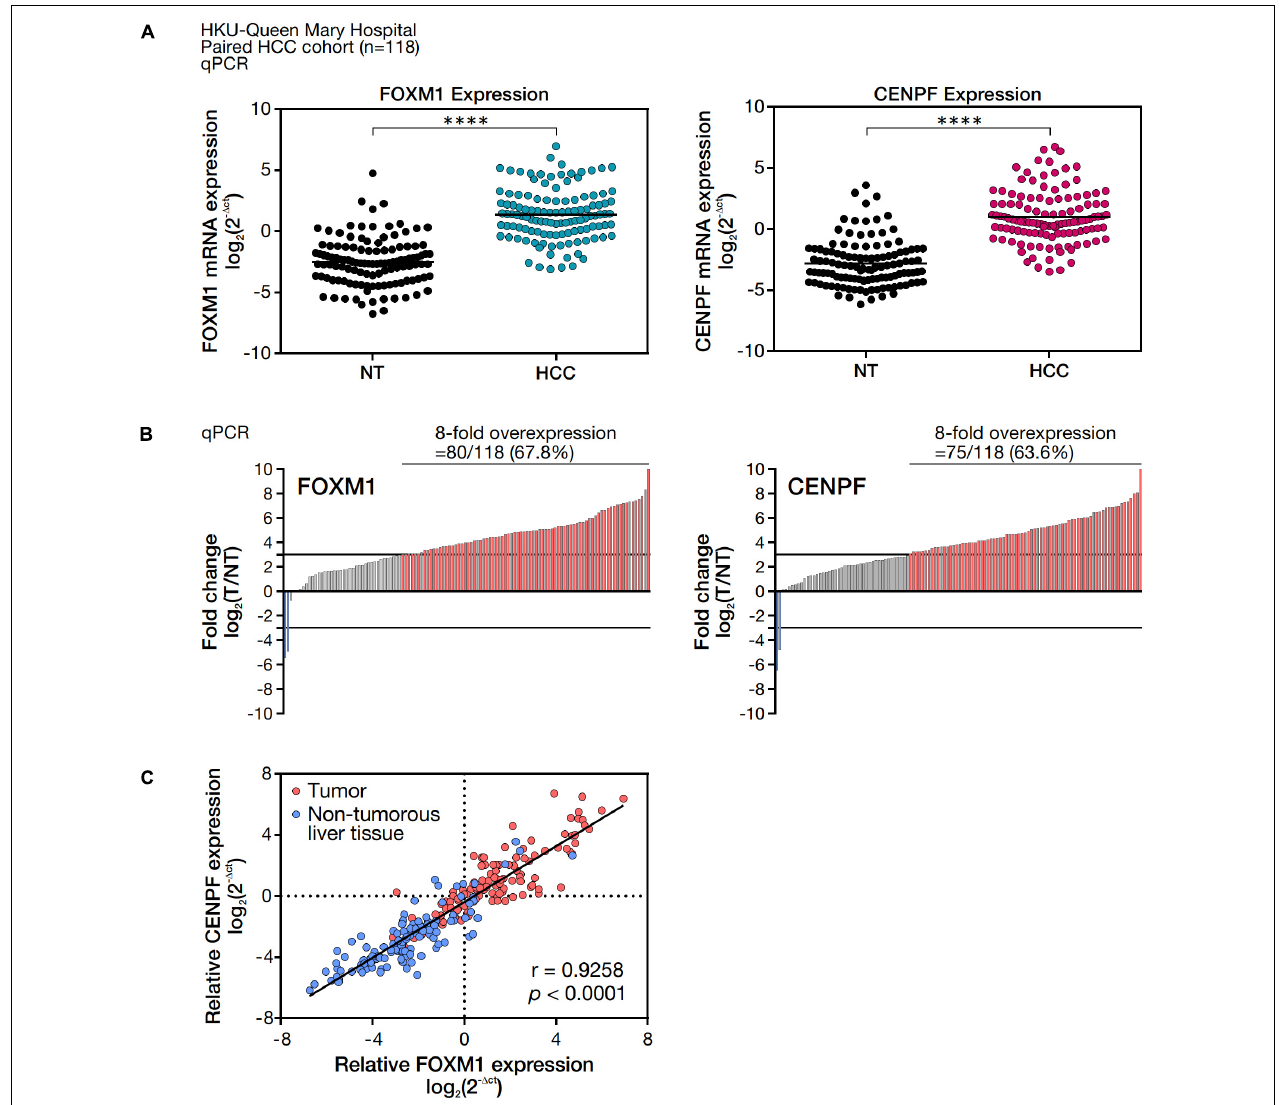
FIGURE 1 | FOXM1 and CENPF mRNA expression level and correlation analysis in HCC tumor and the corresponding non-tumorous liver tissues. (A) mRNA expression levels of FOXM1 and CENPF in 118 pairs of HCC and NT samples. mRNA expressions were normalized by housekeeping gene, HPRT . (B) Waterfall plot showing overall distribution of the fold change of FOXM1 and CENPF mRNA expression in 118 HCC clinical paired samples. (C) Pearson correlation analysis between FOXM1 and CENPF relative mRNA expression. Statistical significance was calculated by one-sample t -test ( ∗∗∗∗ p <